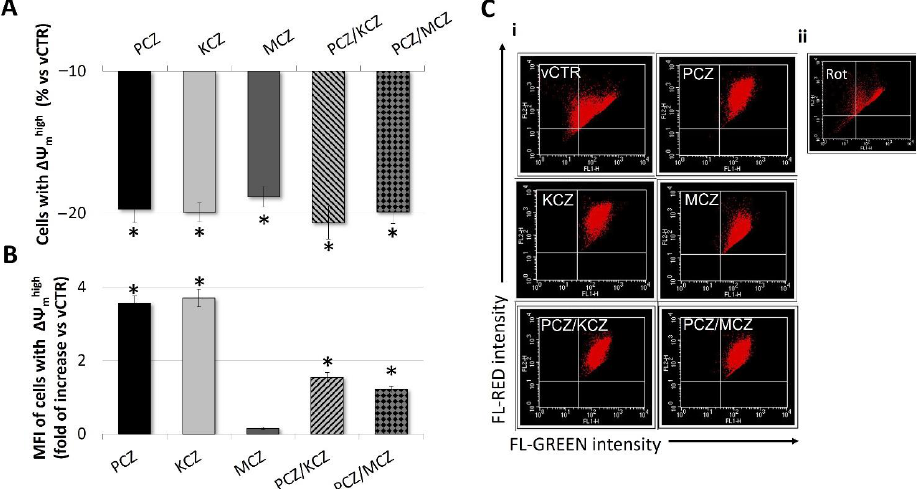
Figure 6. Depolarising effect of azole compounds on mitochondrial membrane potential ( ∆Ψ m ) in TM4 cells. ∆Ψ m was measured by FACS using JC-1 (3 µ M) staining. ( A , B ) Effect of azole fungicides on mitochondrial membrane potential in selected TM4 cells with ∆Ψ mhigh , expressed as ( A ) the percentage of cells with ∆Ψ mhigh (red/orange fluorescence of JC-1 aggregates) and ( B ) MFI emitted by ∆Ψ mhigh populations in vCTR and azole-exposed groups (3 h). Values from three independent experiments are expressed as mean ± SE. One-way ANOVA followed by Dunnett’s test; * p < 0.05. ( C , i ) Representative images of flow cytometry profiles of JC-1-stained samples analysed at 3 h of incubation for vCTR and azole-exposed groups. ( C , ii ) Cells were incubated with 25 mM rotenone for 1 h as a positive control for the abolishment of ∆Ψ m . MFI = mean red fluorescence intensity; Rot =